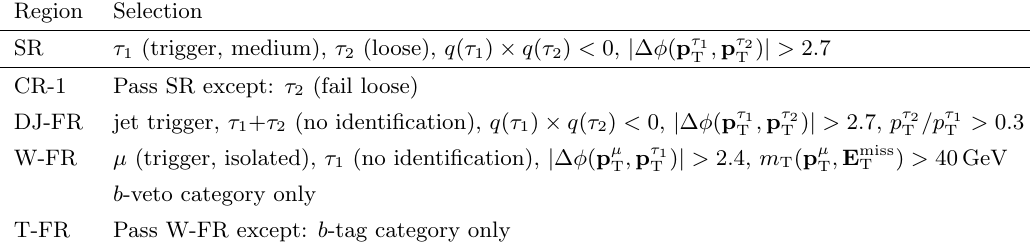
Table 1. De(cid:12)nition of signal, control and fakes regions used in the (cid:28) had (cid:28) had channel. The symbol (cid:28) 1 ( (cid:28) 2 ) represents the leading (sub-leading) (cid:28) had-vis